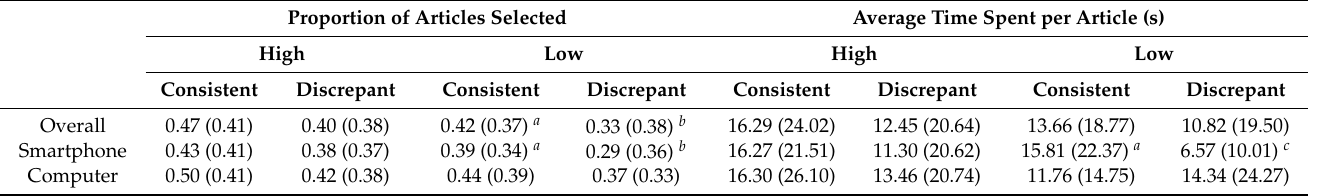
Table 3. Confirmation Bias Among Articles with High and Low Social Cues (Study